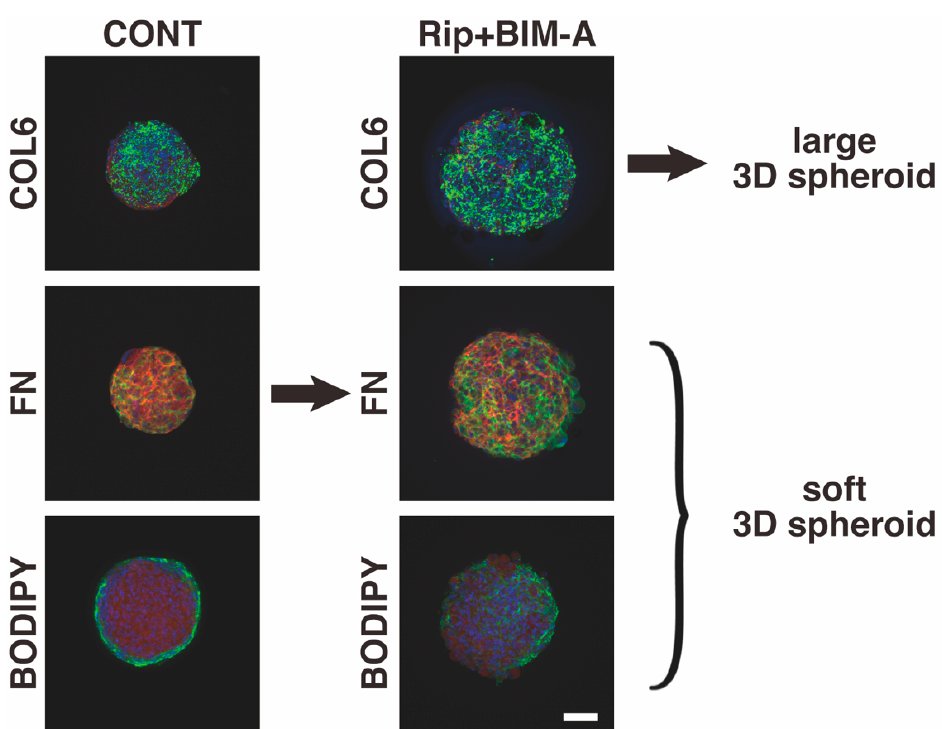
Figure 10. Hypothetical model of the mechanism responsible for inducing huge-sized and soft 3D spheroids caused by the addition of Rip to BIM-A. As shown in the immunolabeled 3D spheroids, a significant upregulation of collagen6 (COL6) as the main component of the structural frame of the 3D spheroid, and relatively insufficient amounts of lipid and fibronectin (FN) content within the 3D spheroid, represent a possible mecha- nism for the formation of the huge-sized and soft 3D spheroids upon the administration of ROCK-i